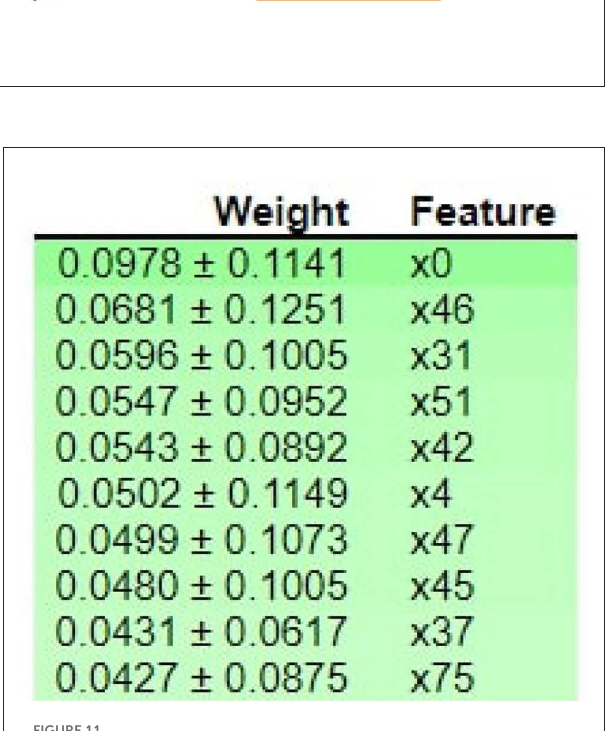
FIGURE11 ELI5-based feature